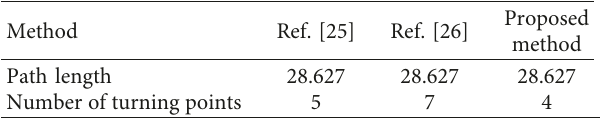
Figure 7: Comparison of path planning of different methods. (a) Ref [26]. (b) Ref [27]. (c) Proposed methods. Table 2: Comparison of path length and number of turning points of different